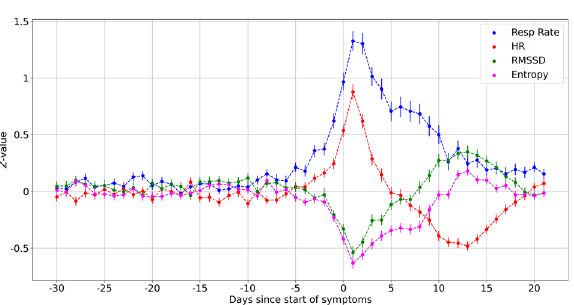
Fig. 2 Variation of metrics with day. Shown are the Z -scores for respiration rate, heart rate, RMSSD, and entropy. Day 0 ( D 0 ) represents the start of symptoms. The respiration rate and heart rate are elevated during times of sickness, while the RMSSD and entropy are decreased. These metrics may change a few days prior to the start of symptoms. The heart rate decreases on average, following day D + 7 , and returning to the base value by day D + 21 . The HRV metrics are slightly elevated on average during this period. We did not notice a decrease in respiration rate during this phase. Error bars represent the standard error of the mean.